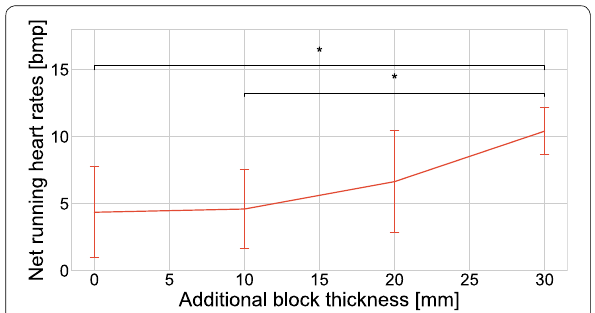
Fig. 4 Net running heart rates and additional block thickness. 30 mm thick blocks increased the heart rates compared to that without blocks. This single star (*) represents results of the paired t-test ( P < 0.05 ). These error bars represented standard deviation of